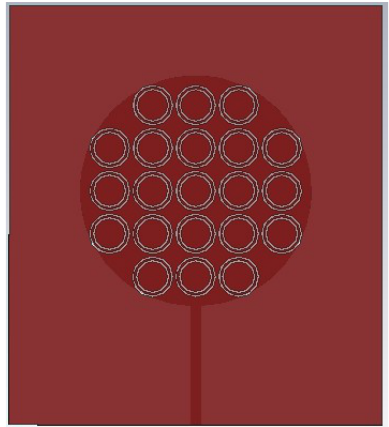
Figure 23: Patch loaded with CRR array with defected ground.